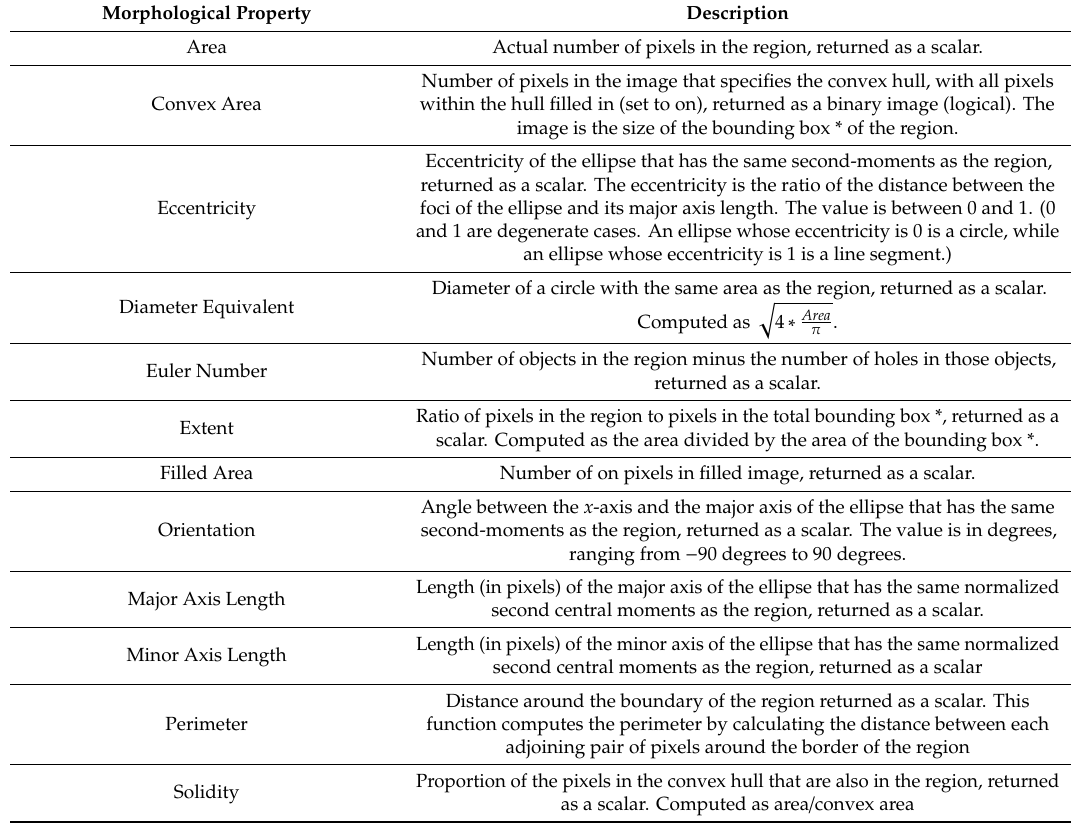
Table 3. Morphological properties calculated for the tomato plants at early stages images with di ff erent levels of organic